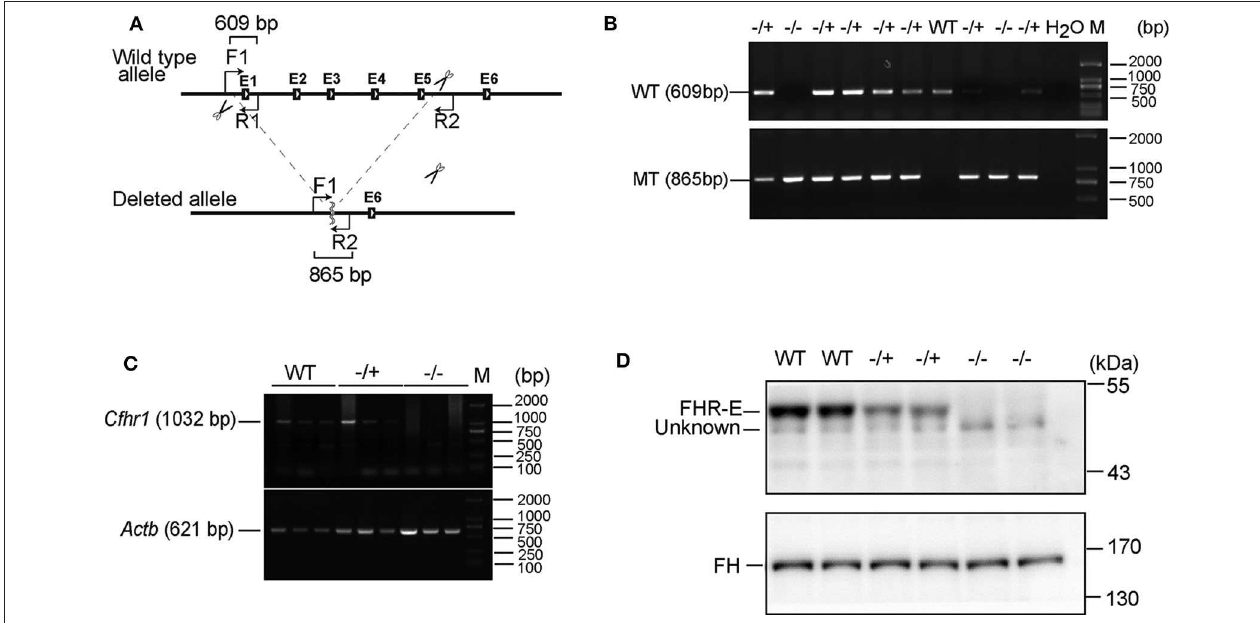
FIGURE 2 | Verification of the absence of FHR-E in Cfhr1 -KO mice. (A) The scheme of Cfhr1 knockout strategy. F1, R1, and R2 indicate the primers used for genotyping. The expected bands amplified by two pairs of primers were 609 and 865 bp, respectively. (B) Verification of Cfhr1 deletion from genome level. The upper bands were amplified with primers F1 and R1. These bands can only be amplified in wild-type and heterozygous mice and cannot be amplified in homozygous mice because of the absence of the sequence of primer R1. The lower bands were amplified with primers F1 and R2. These bands can only be amplified in heterozygous and homozygous mice. The sequence between primers F1 and R2 is too long to be amplified in wild-type mice. (C) Verification of Cfhr1 deletion from RNA level. Hepatic RNA of mice of different genotypes was extracted and reversely transcribed. Primers spanning the open reading frame (ORF, 1,032 bp, NM_015780) of Cfhr1 were used for RT-PCR. Actb was used as a semi-quantitative control. (D) Verification of FHR-E deficiency at the protein level. Plasma proteins of mice with different genotypes were separated by 8% SDS-PAGE gel. Proteins were transferred to the membrane and analyzed by Western blotting using anti-serum to mouse FHR-E, which was generated in rabbit immunized with a recombinant peptide of CCP 3–5 of FHR-E. An about 50 kDa specific FHR-E band was detected in WT and heterozygous mice, but not in homozygous mice. “Unknown” indicates an unknown protein recognized by anti-FHR-E antibody. Western blotting of FH was regarded as an internal